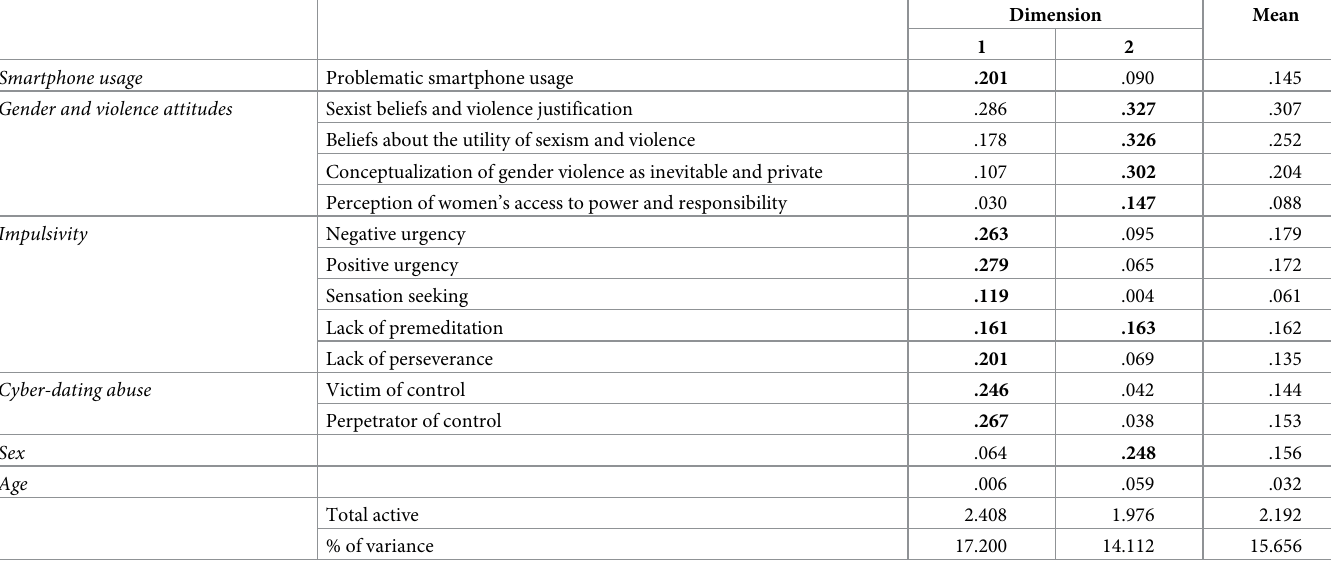
Table 2. Ability of the variables to discriminate between the two